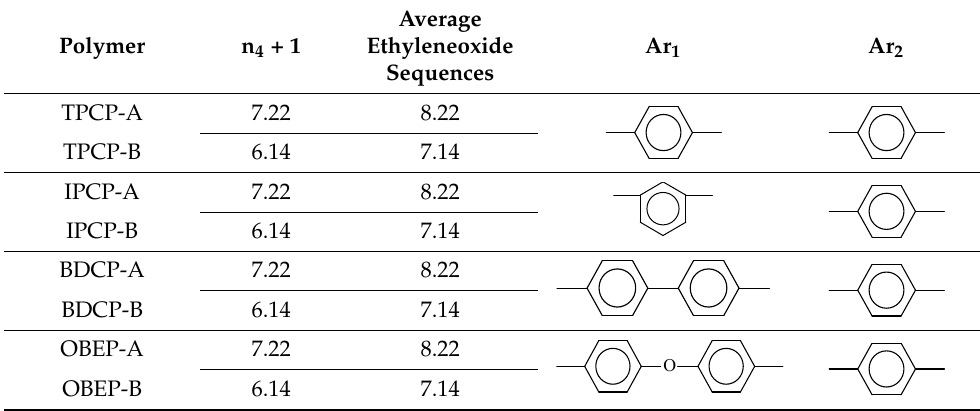
Table 1. Structure of the synthesized